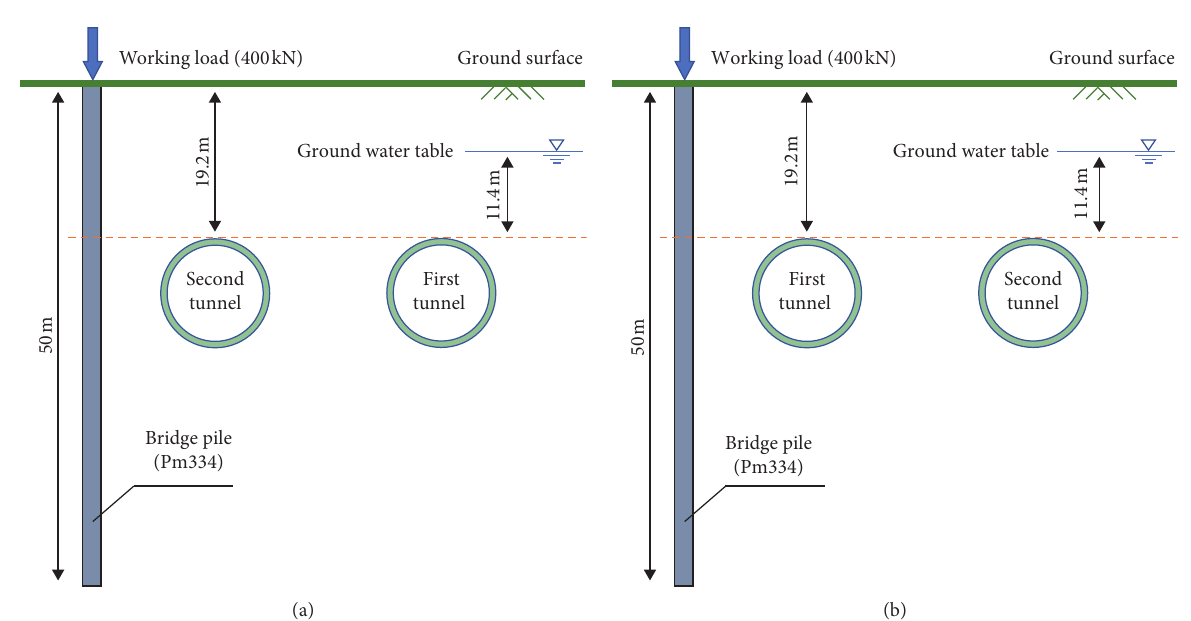
Figure 6: Different tunnel construction sequences. (a) Condition (a). (b) Condition